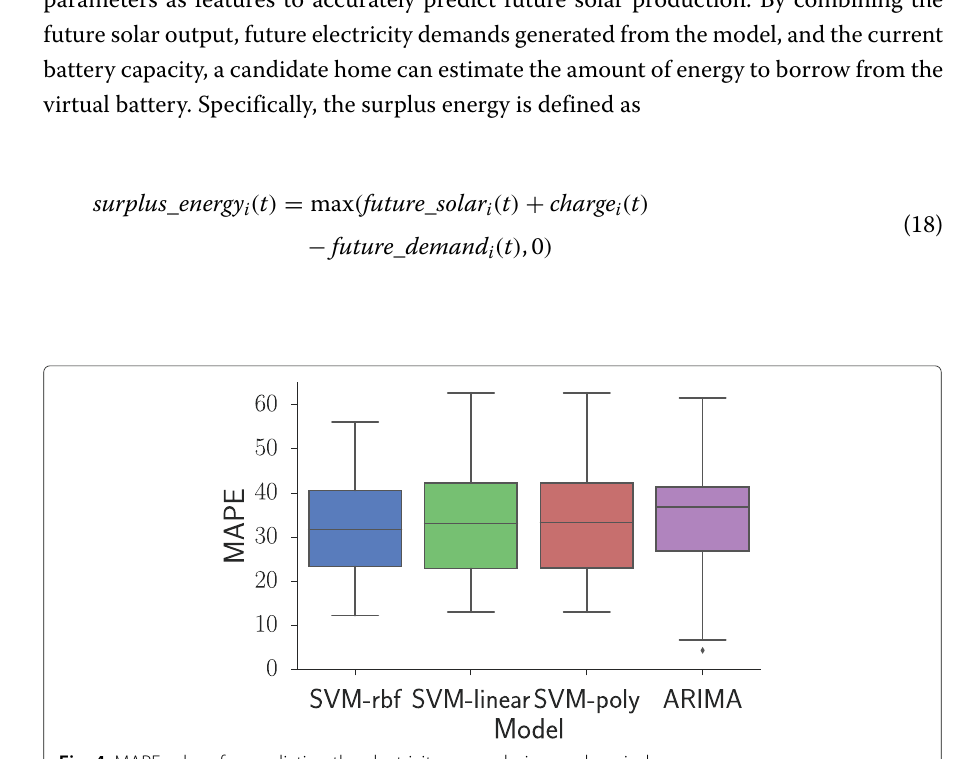
Fig. 4 MAPE values for predicting the electricity usage during peak